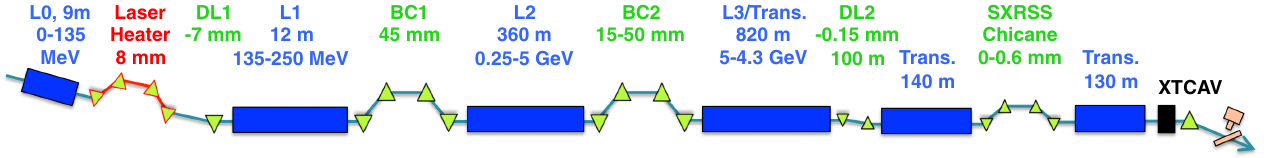
FIG. 1. Schematic of the LCLS accelerator showing the accelerating/transport (blue) and dispersive regions (green) that contribute to MBI. For dispersive regions, the R 56 is given in mm. Diagram includes the laser heater (in red), accelerating sections (L0-L3), transport sections (trans.), bunch compressors (BC1-BC2), doglegs (D1-D2), and the soft x-ray self-seeding chicane (SXRSS).